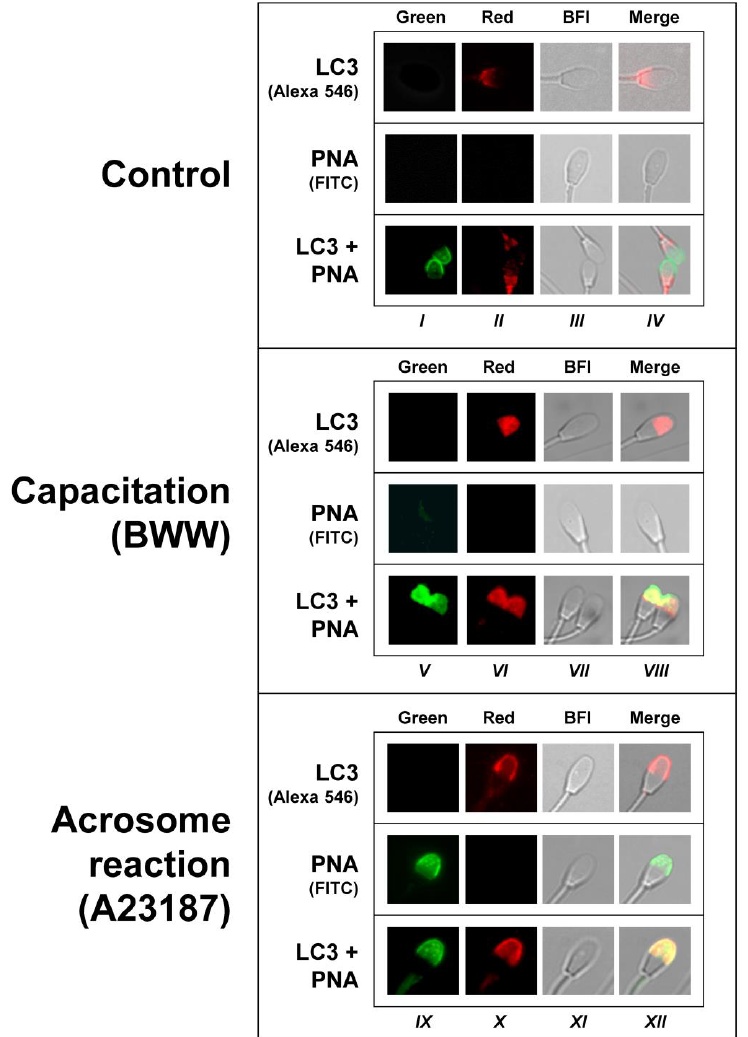
Figure 4. Simultaneous localization of LC3 and PNA in control, capacitated, and acrosome-reacted stallion sperm cells. Stallion spermatozoa were incubated in BWW for 3 h at 37 °C (Capacitation, Columns V to VIII), with the addition of 5 µM A23187 during the last 30 min of incubation (Acrosome reaction, Columns IX to XII), or they were processed without incubation (Control; Columns I to IV). The three populations (i.e., control, capacitated, and acrosome-reacted cells) were then incubated with a commercial anti-LC3 antibody followed by incubation with a secondary antibody labeled with Alexa 546 (LC3, Alexa 546), or they were labeled with an FITC-conjugated lectin from Arachis hypogaea (PNA-FITC) or with a combination of both probes (LC3 + PNA) (see Methods). The images were obtained with an inverted fluorescent microscope equipped with a 100× objective and the appropriate filters set to acquire green (Columns I, V, and IX) and red images (Columns II, VI, and X). Bright-field images (BFI, Columns III, VII, and XI) were also acquired. A superposition of these three images was constructed with the image processing software ImageJ (Merge, Columns IV, VIII, and XII), appearing yellow in the areas where the probes potentially colocalized. These